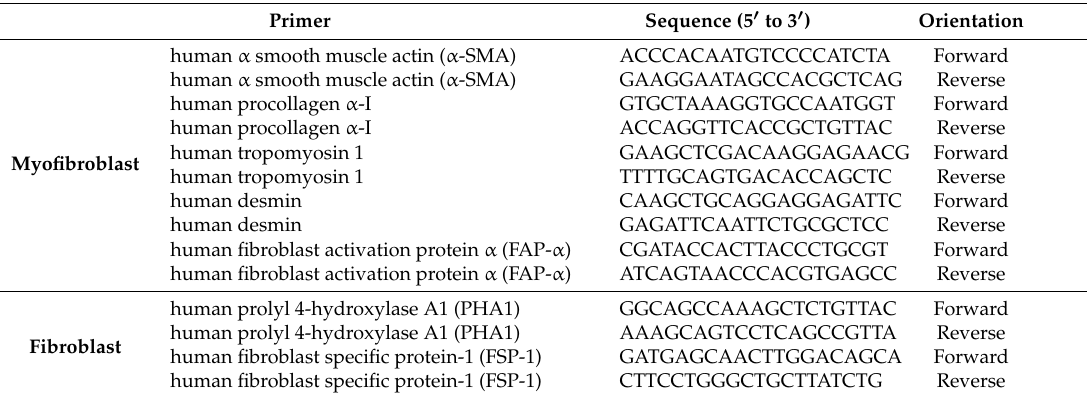
Table 1. Markers for myofibroblasts and